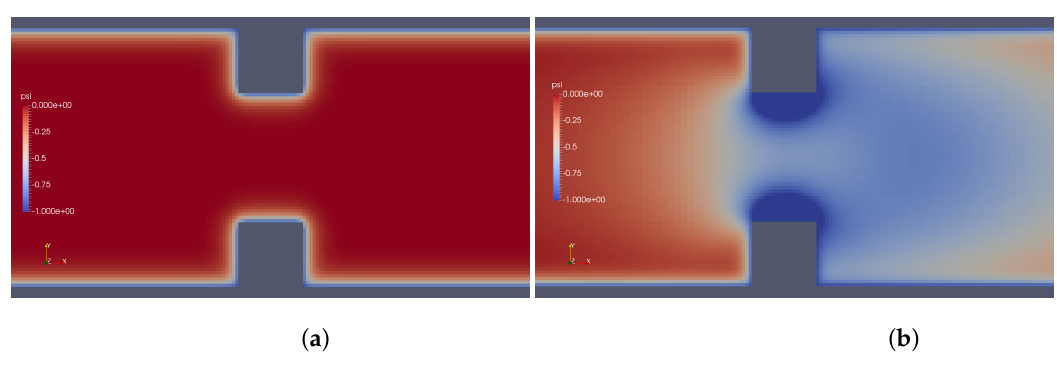
Figure 17. Potential ψ . ( a ) ω ∗ = 0 and ( b ) ω ∗ = 6.0 × 10 − 3 .